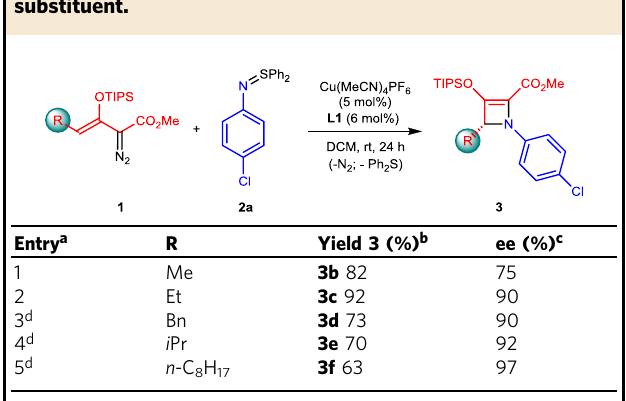
Table 2 Scope of enoldiazoacetates: effect of the carboxylate